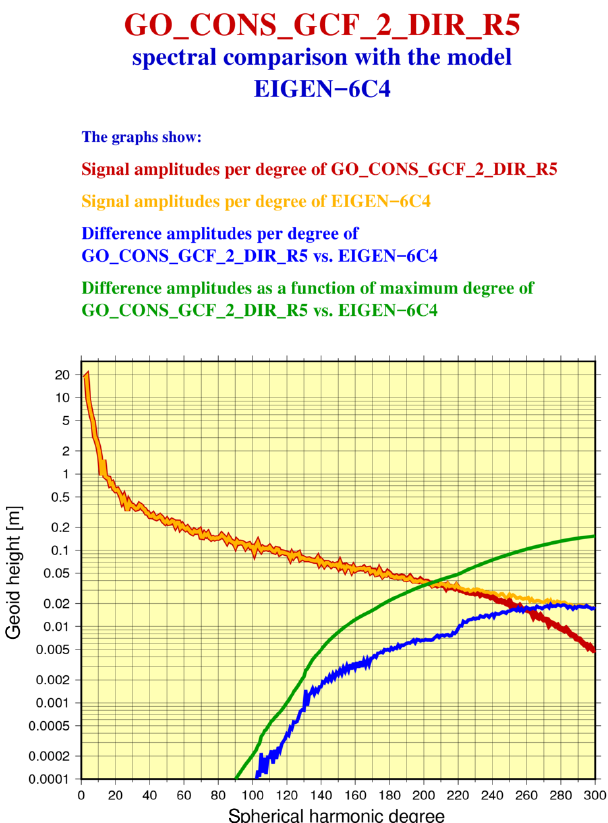
Figure 16. Spectral comparison of two static global gravity field models, GOCO05S and EIGEN-6C4. Note that the comparisons are performed for each degree separately. GOCO05S is a satellite-only model, whereas the EIGEN6C4 is a combined model that uses both the satellite and terrestrial measurements. The blue curve repre- sents the difference in the amplitude of the GOCO05S and EIGEN- 6C4 combined static gravity field models per degree, whereas the green line represents the cumulative difference amplitudes of the two models as a function of maximum degree. Note the increas- ing difference as the degree increases due to the contribution of the terrestrial gravity data to